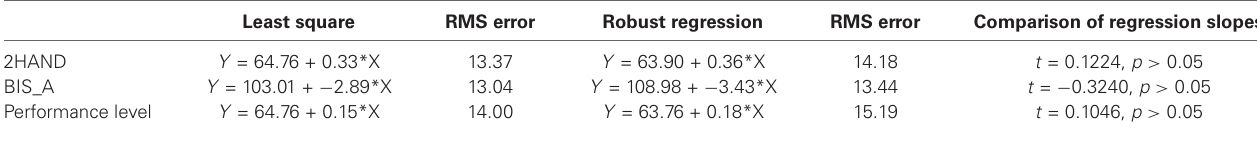
Table 1 | Regression coefficients for standard regression models and for robust regression analyses . Least square RMS error Robust regression RMS error Comparison of regression